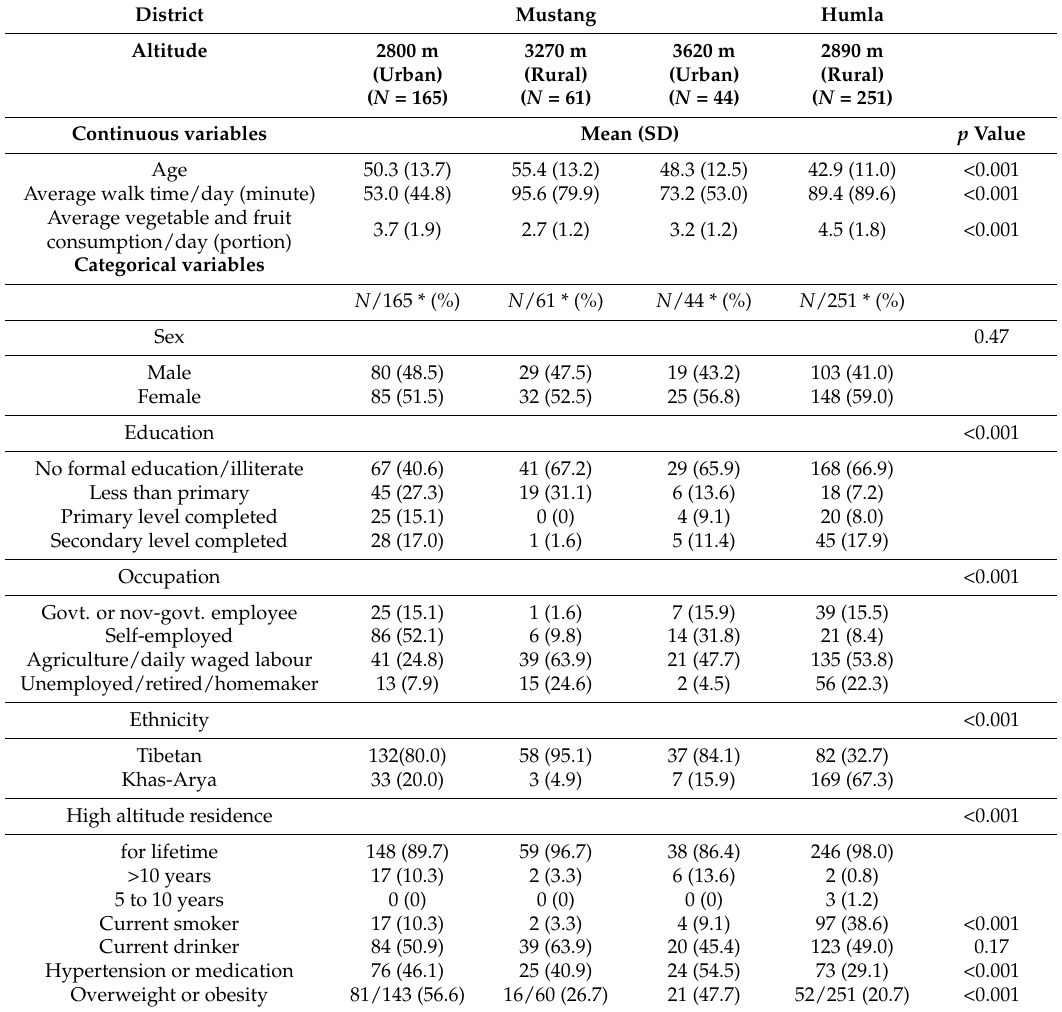
Table 1. Description of study participants by altitude